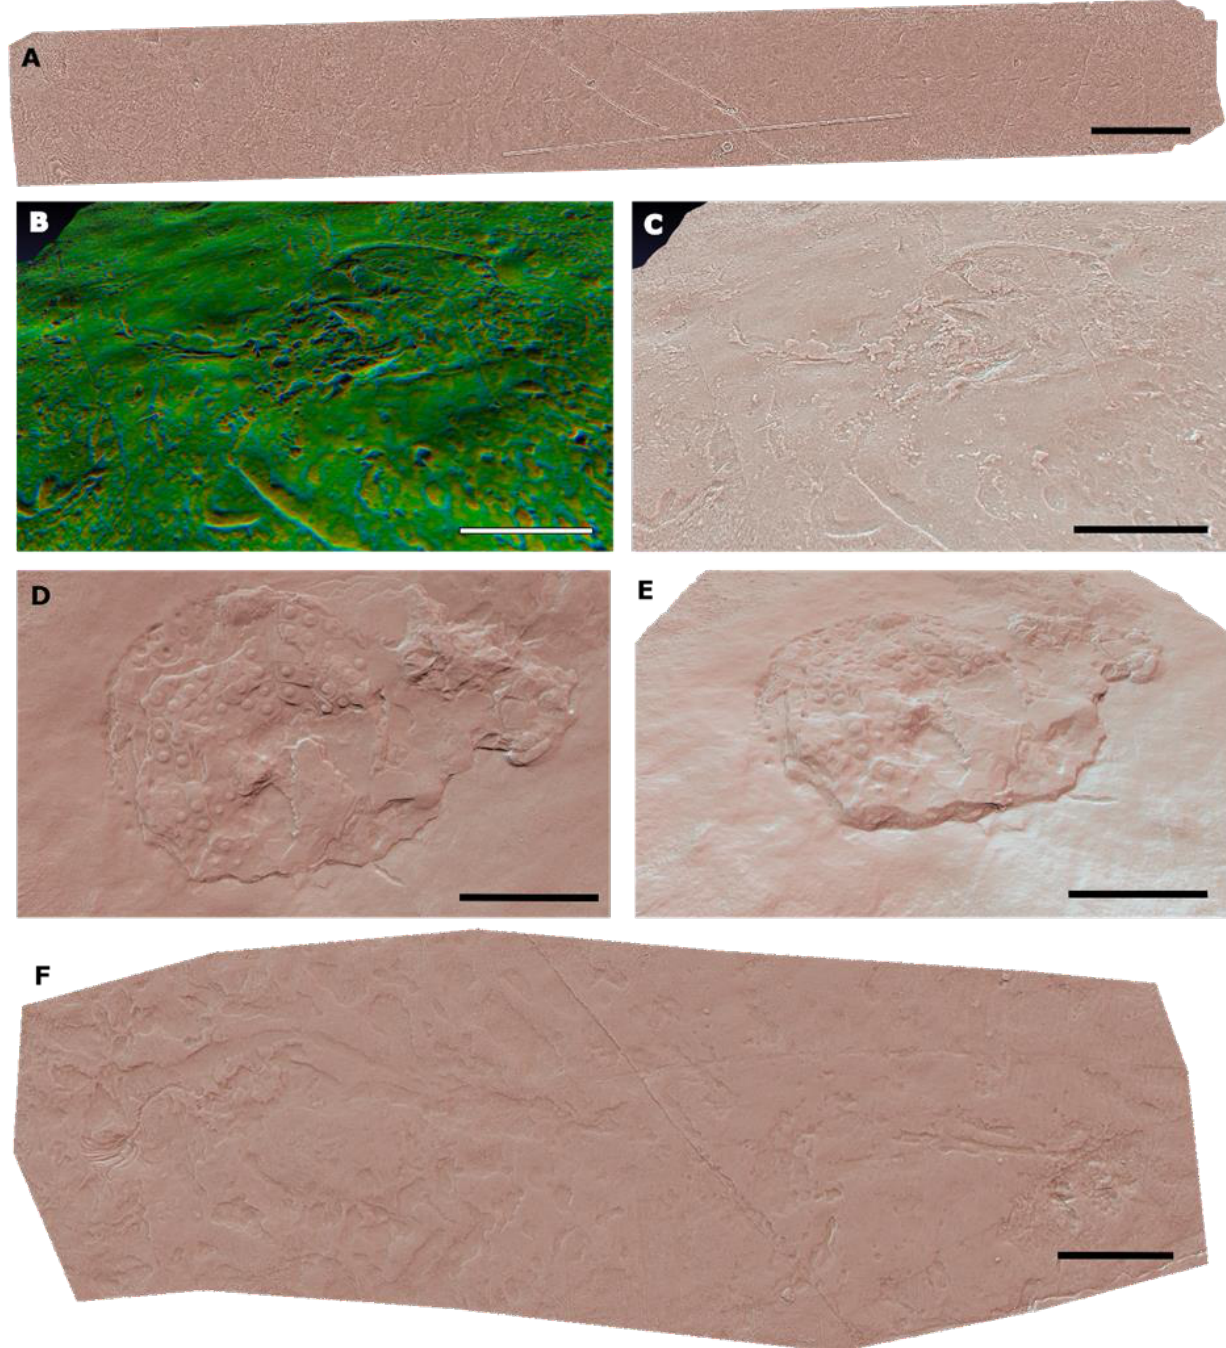
Figure 9. The 3D photogrammetric modelling of the most relevant body and trace fossils (generated by J.B.). ( A ) Trace fossil representing swimming behavior; scale is 50 cm. ( B , C ) Resting trace of a Rhinobatidae; scale is 25 cm. ( D , E ) Vertical and oblique 3D views of a Heterocidaris ; scale is 5 cm. ( F ) Vertical view of the Krinodromos bentou 3D model revealing the agonistic trail left by a stalked crinoid; scale is 25 cm. Model B is highlighted by the application of shadows and curvature map. Warm tones correspond to concave areas and cool tones to convex areas. The remaining models presented are highlighted by the radiance scaling method [33].